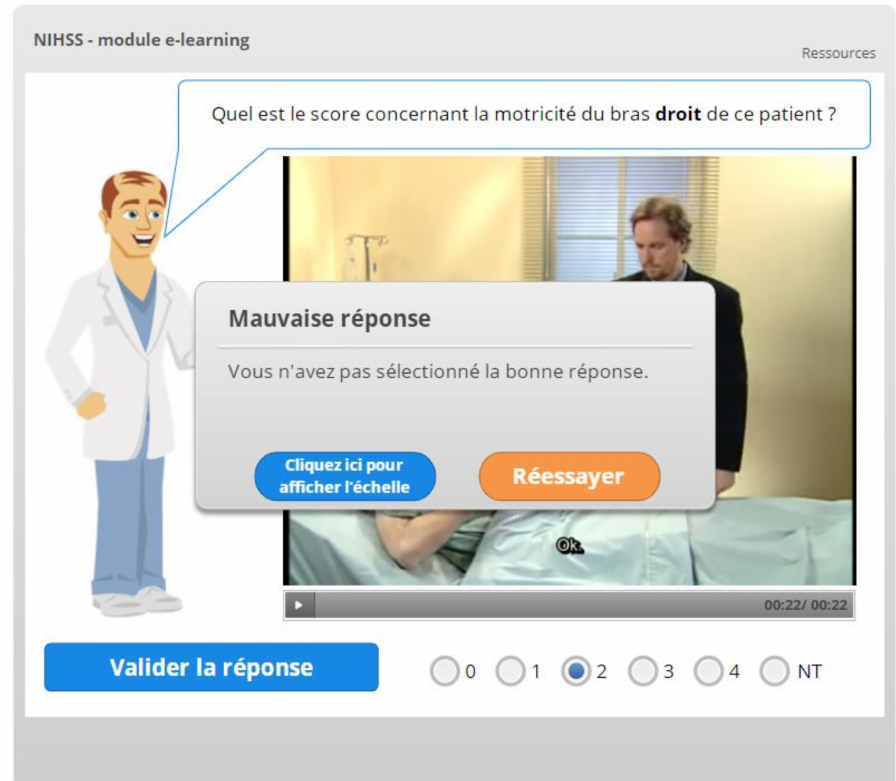
Figure 4. Feedback displayed after a wrong